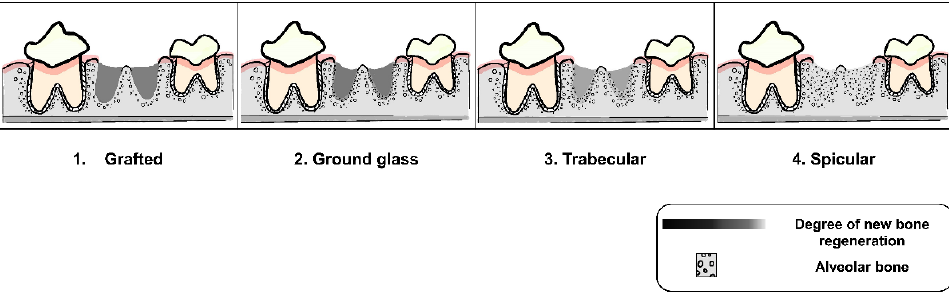
Figure 3. Characteristics of alveolar bone formation of post-extraction sockets in four grades (Criteria B).